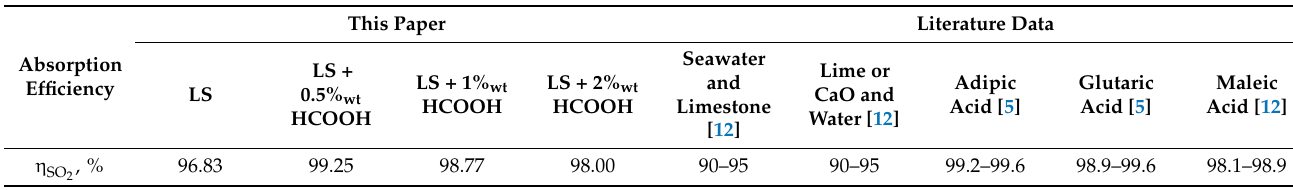
Table 4. Comparative data of SO 2 removal from flue gases by cleaning.